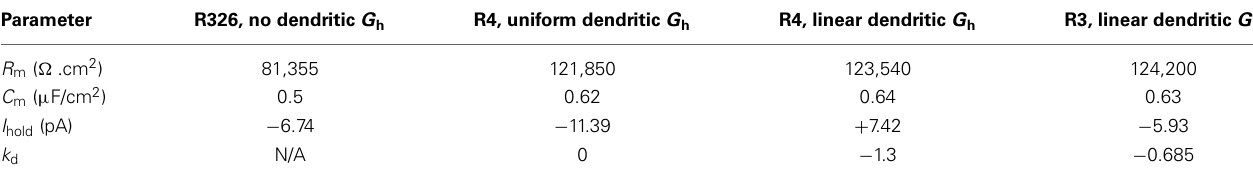
Table 5 | Fitted specific membrane resistivity and capacitance values in the models. Model Linear dendritic G h distribution Sigmoidal dendritic G h distribution Morphology 1 (n = 6) Morphology 2 (n = 4) Morphology 1 (n = 5) Morphology 2 (n = 4) R m ( (cid:3) . cm 2 ) 116,300 ± 9,103.88 64,364.7 ± 7,320.86 117,185 ± 9,963.84 62,065.2 ± 4,620.38 C m ( μ F/cm 2 ) 0.7084 ± 0.0744 0.7113 ± 0.0747 1.2001 ± 0.1556 1.2094 ± 0.1448 The means and standard deviations of the specific membrane resistivity (R m ) and specific membrane capacitance (C m ), grouped according to model morphology and dendritic G h distribution (linear or sigmoidal).